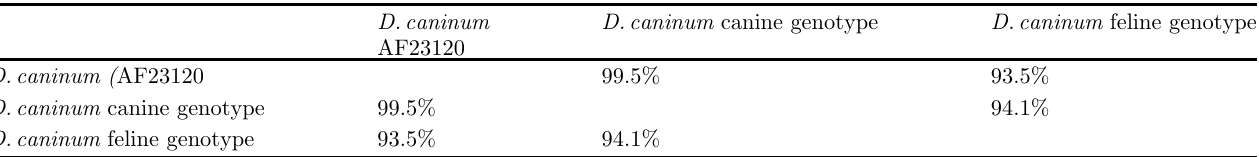
Table 4. Percentage DNA sequence identity obtained from approximately 650bp PCR product in D. caninum positive samples.